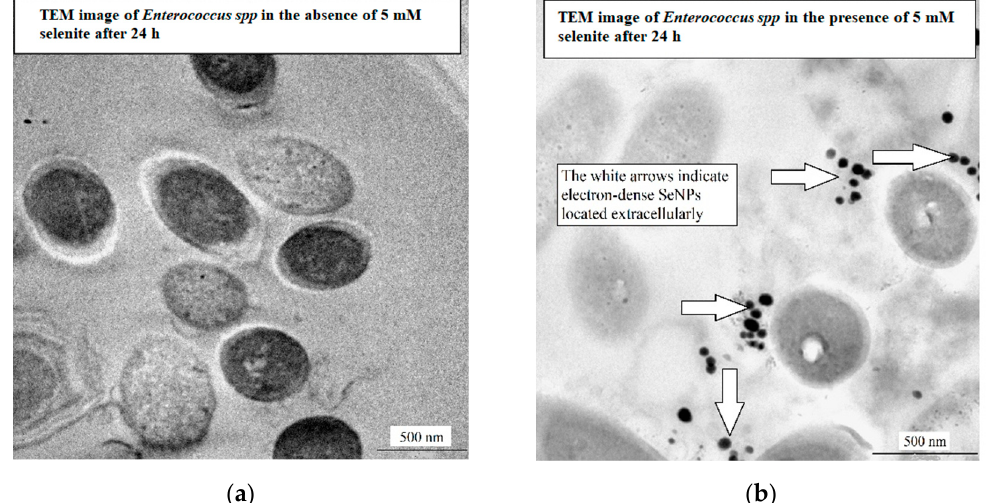
Figure 5. TEM images for Enterococcus spp. grown in the ( a ) absence of selenite and ( b ) presence of 5 mM selenite after 24 h.